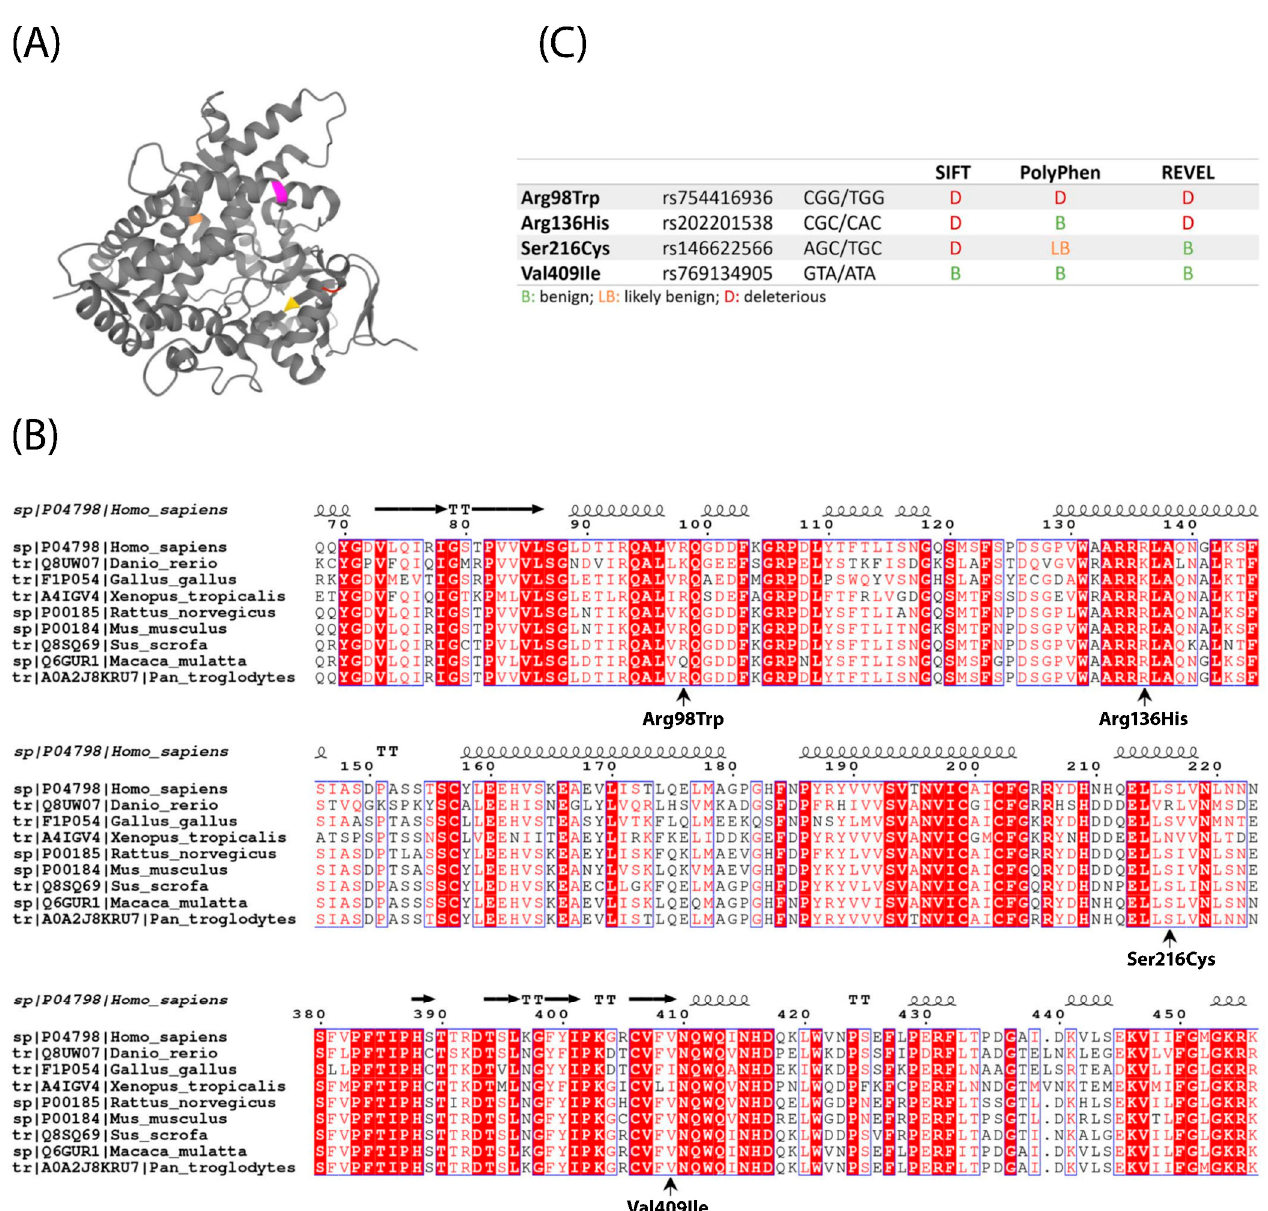
Figure 1. ( A ) PDB structure (4I8V) of human CYP1A1 with the mutated residues highlighted in different colors: Arg98 (red), Arg136 (pink), Ser216 (orange), and Val409 (yellow). ( B ) Partial alignment of CYP1A1 protein sequences from several vertebrate species, with the four AFF-associated mutations indicated under it. Species included are human ( Homo sapiens ), macaque ( Macaca mulata ), chimpanzee ( Pan troglodytes ), mouse ( Mus musculus ), rat ( Rattus norvegicus ), pig ( Sus scrofa ), zebrafish ( Danio rerio ), Western clawed toad ( Xenopus tropicalis ) and chicken ( Gallus gallus ). ( C ) Predictions of pathogenicity of the four AFF-associated CYP1A1 variants according to SIFT, Poly-Phen and Revel.